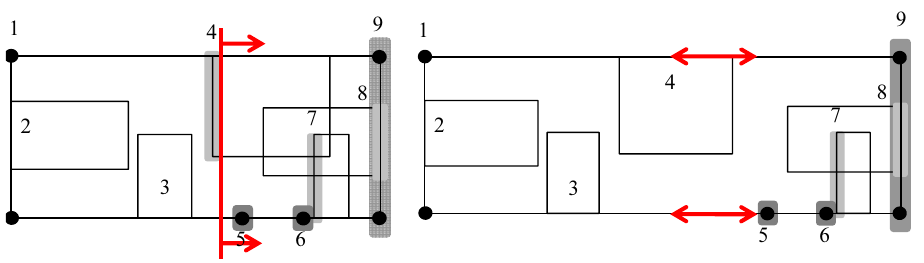
Figure 16. The step of the plane sweep algorithm that resolves overlaps for Label